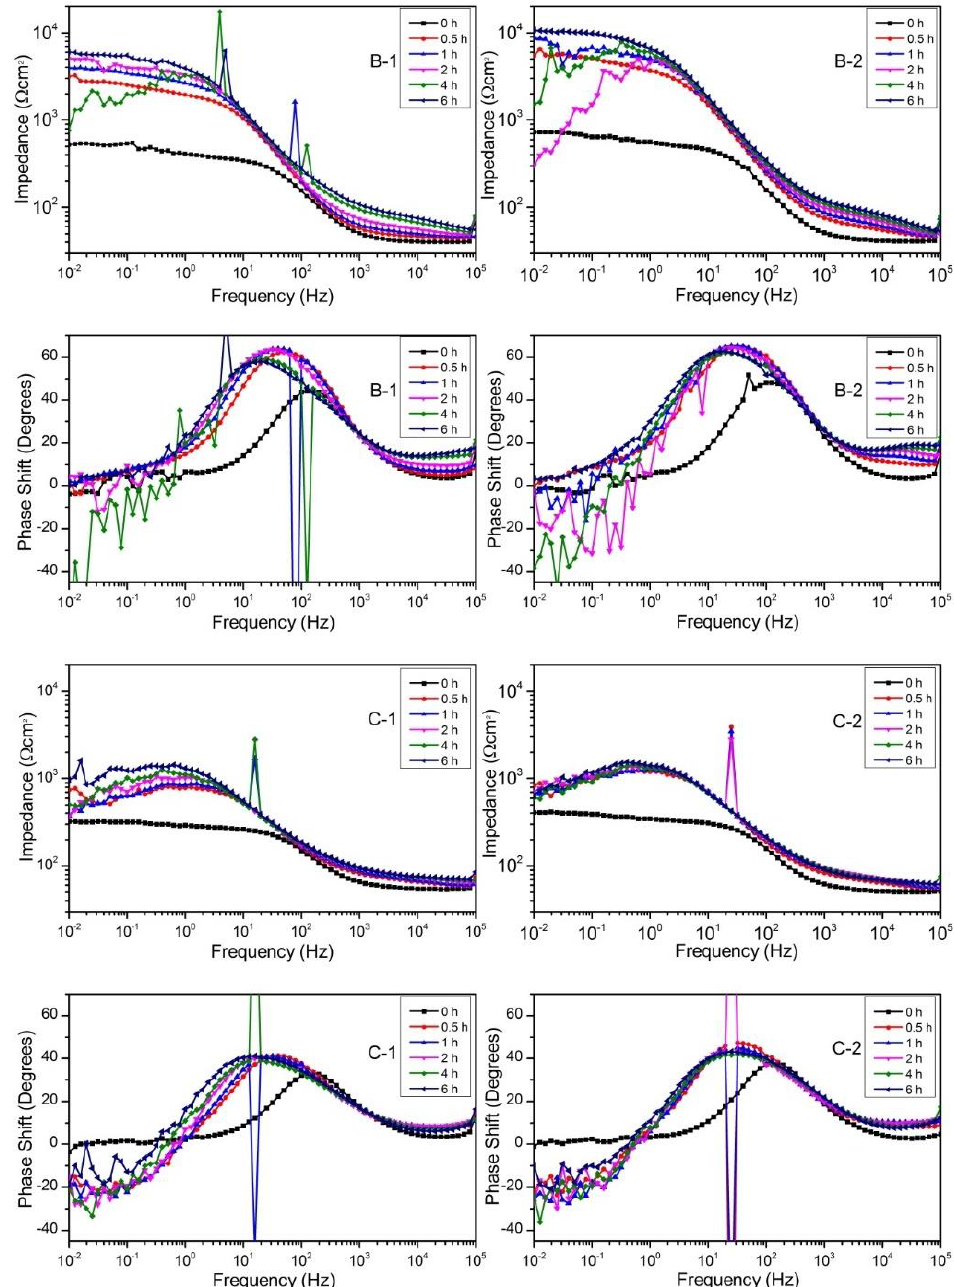
Figure 10. Bode plots of samples B-1, B-2, C-1, and C-2 immersed in Hank’s solution. Table 4. Corrosion potential ( E corr ) and corrosion current density ( I corr ) of the as fabricated samples.